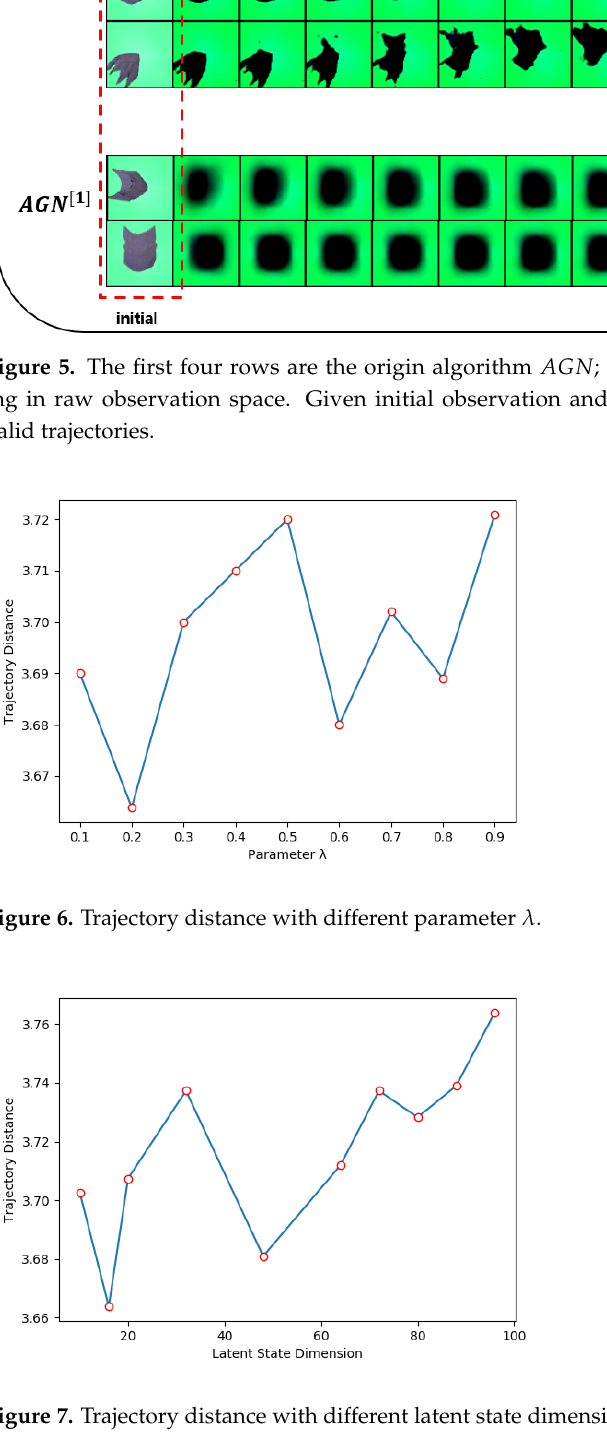
Figure 7. Trajectory distance with different latent state